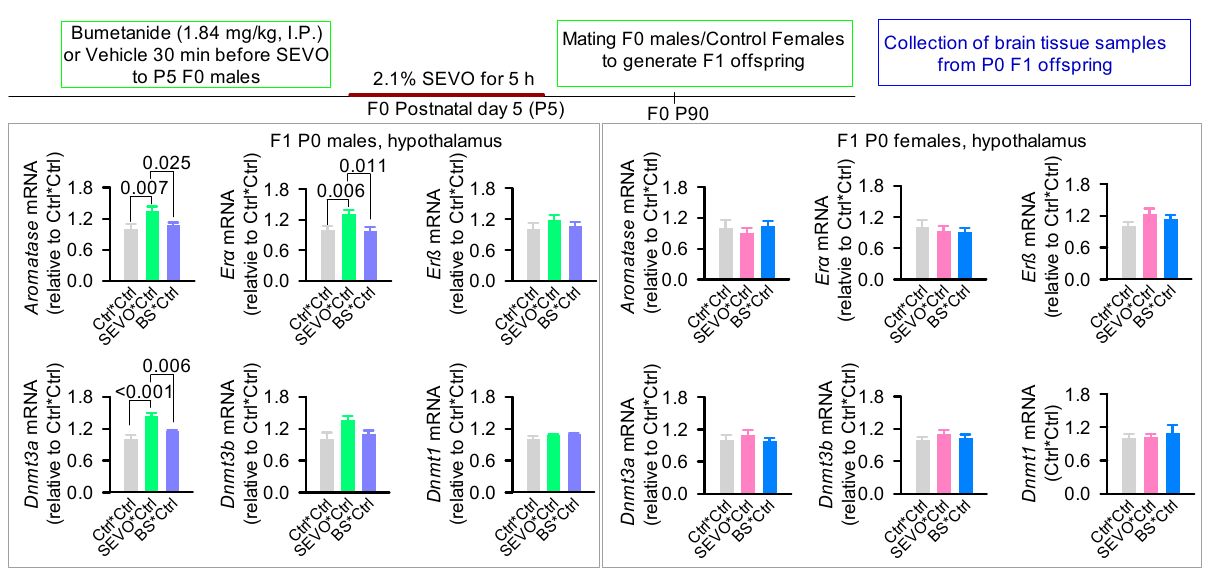
Figure 2. The postnatal day (P) 0 F1 males, but not females, of SEVO-exposed F0 males and Control females had abnormalities in expressions of genes that are essential for brain masculinization during a critical period of brain sexual differentiation. Bumetanide deterred F0 SEVO effects in F1 male offspring. Top panel: Illustration of experimental design. Data are mean ± SEM of 5 rats/group/sex. The p -values of multiple pairwise comparisons are shown in the respective plots above the horizontal lines. I.P.: Intraperitoneal; Er α : estrogen receptor α gene; Er β : estrogen receptors β gene; Dnmt3a: DNA methyltransferase 3a gene; Dnmt3b: DNA methyltransferase 3b gene; Dnmt1: DNA methyltransferase 1 gene. See Supplementary material for details.